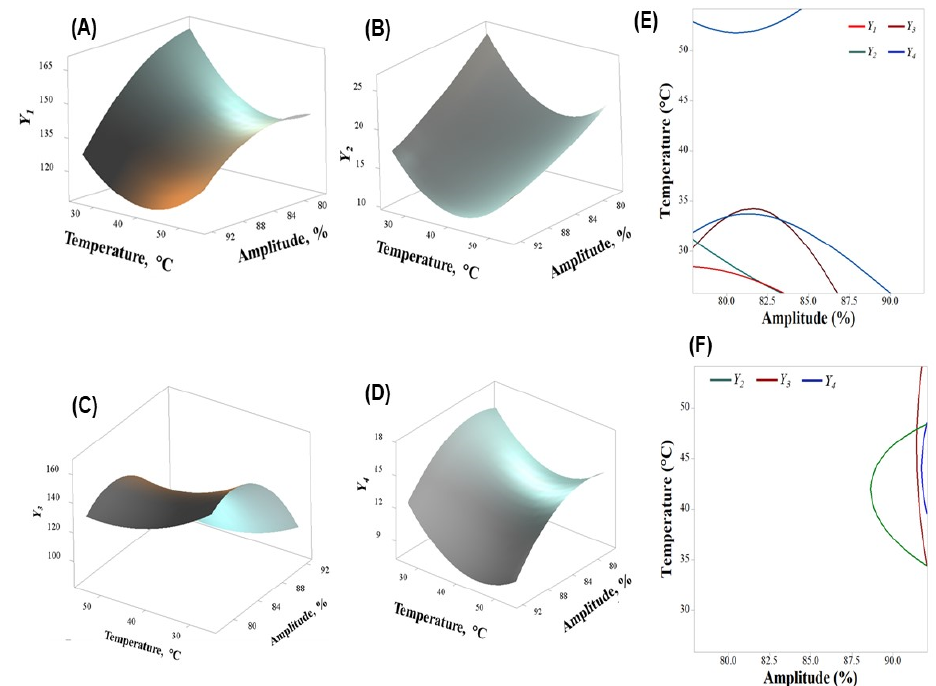
Figure 1. Representation of the response surfaces for surface models for Y 1 , DPPH in mg Trolox/100 g ( A ); Y 2 , ABTS in mg Trolox/100 g ( B ); Y 3 , FRAP in mg Fe 2+ /100 g ( C ); Y 4 , total phenolic content in mg GA/100 g ( D ) and of overlaid contours at upper ( E ), and lowest values of responses ( F ).